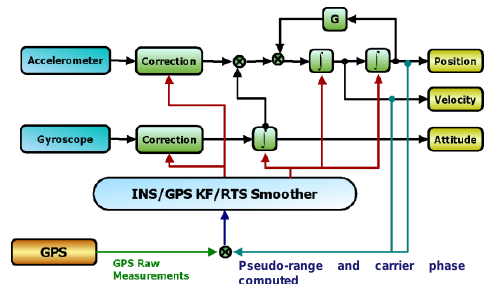
Figure 3 The integration architecture of TC (closed loop)